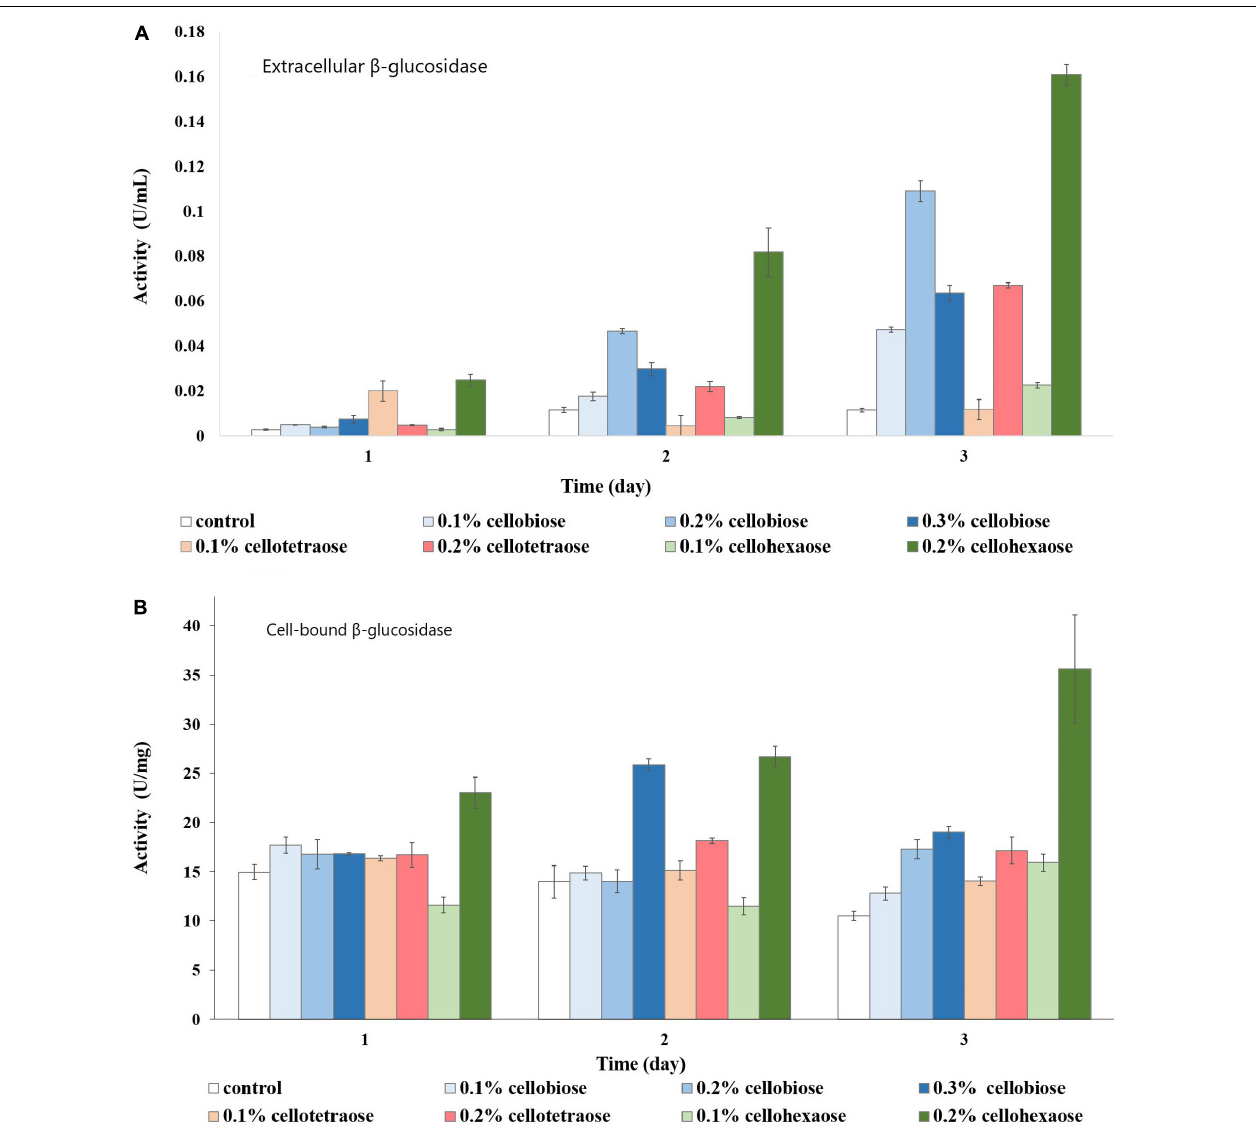
FIGURE 10 | β -glucosidase activity of glycerol-grown biomass in the presence of different inducers and using pNPG as substrate. (A) Extracellular β -glucosidase activity; (B) Cell-bound β -glucosidase